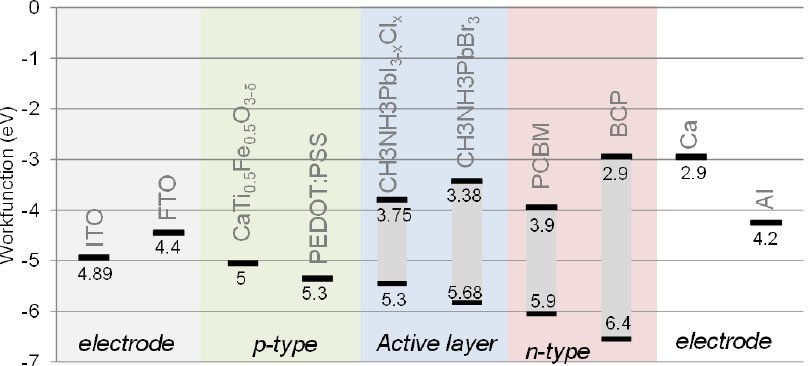
Figure 8. Work functions measured on CaTi 0.5 Fe 0.5 O 3−δ perovskites and compared to ITO, FTO, PEDOT: PSS, Ca and Al work functions and CH 3 NH 3 PbI 3 − x Cl x , CH 3 NH 3 PbBr 3 , PCBM, and BCP energy levels.